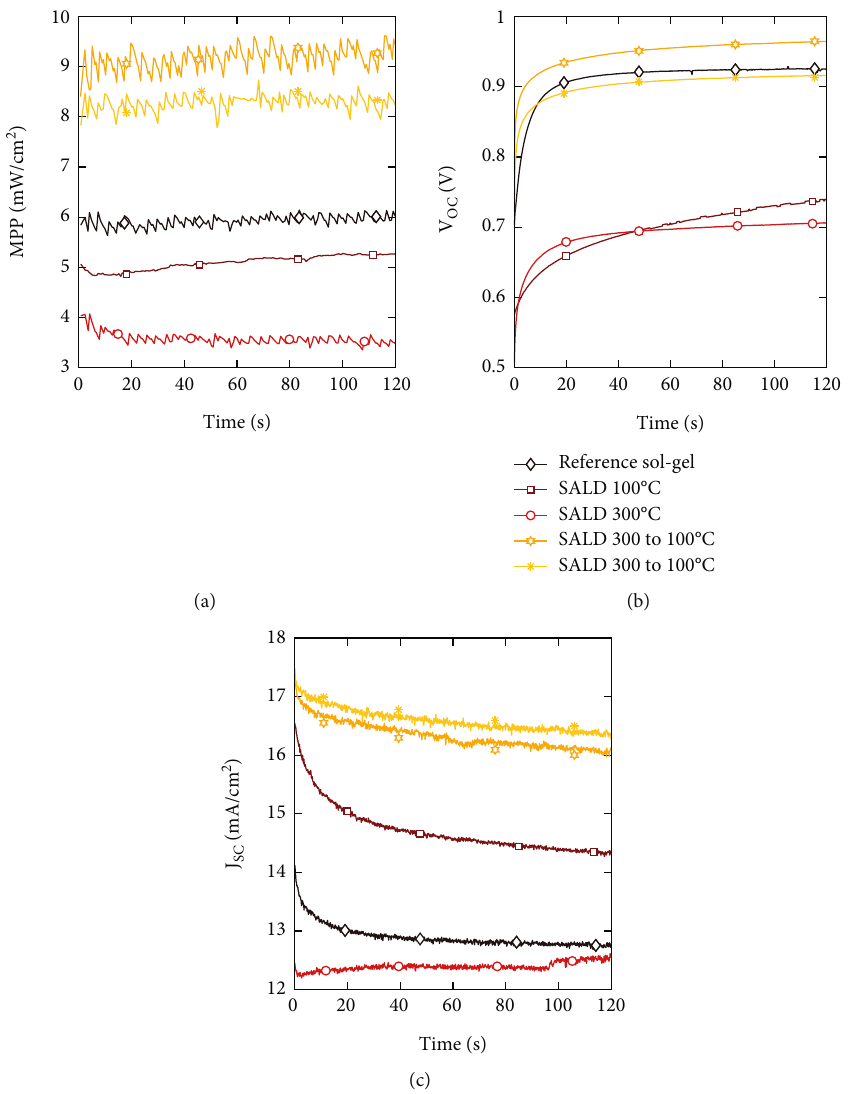
Figure 7: Steady state device characteristics of solar cells fabricated on TiO from 300 ° C to 100 ° C (the latter for two di ff erent batches of devices with high reproducibility). Sol-gel-based TiO devices without PCBA modi fi cation: (a) maximum power-point (MPP), (b) V OC , and c) J SC tracking over